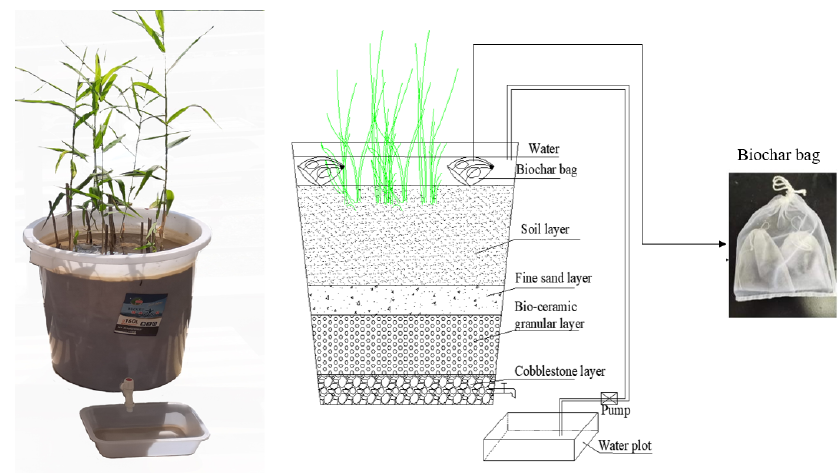
Figure 1. A schematic diagram of the simulated constructed wetland and the biochar bags. The constructed wetland substrate consisted of a 25 cm soil layer, a 5 cm layer of fine sand, and a 10 cm layer of ceramsite, a 5 cm layer of cobblestone from top to bottom, and the layers were separated by fine gauze. Except for soil, substrates were washed with water before loading to avoid extrinsic contaminants.